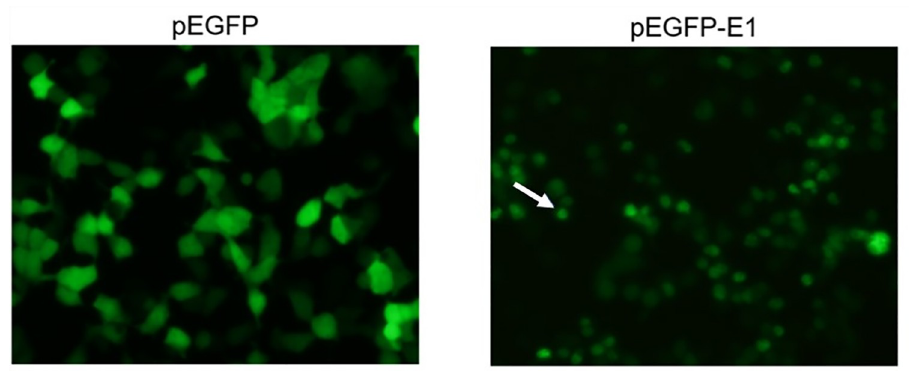
Fig 1. pEGFP and pEGFP-E1 transfected HEK 293T cells. Green fluorescence was observed in HEK 293T cells transfected with pEGFP alone and with pEGFP-E1 transfected cells under fluorescence microscopy. Arrow denotes nuclear localization.